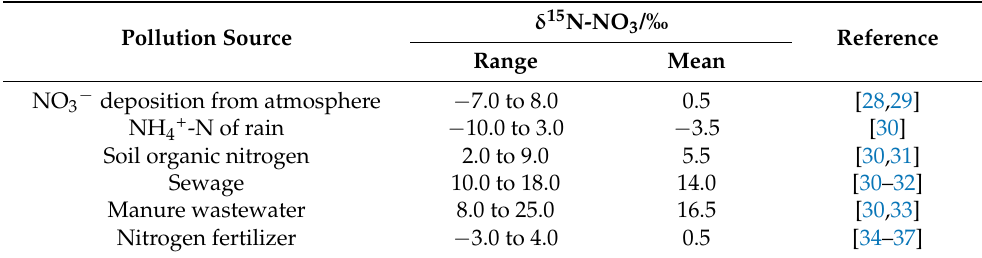
Table 1. Range of δ 15 N-NO 3 for different sources.